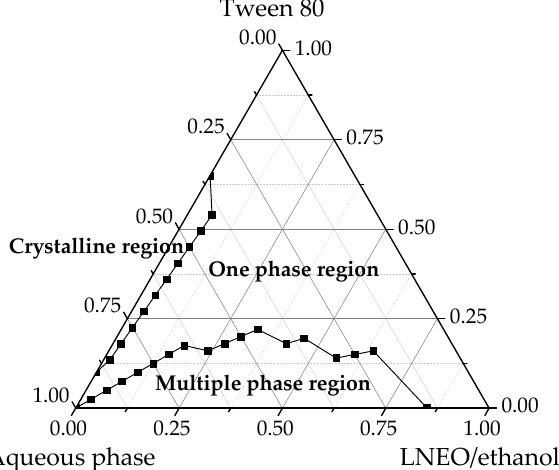
Figure 1. Pseudo-ternary phase diagram of the aqueous phase/Tween 80/ethanol/LNEO system.